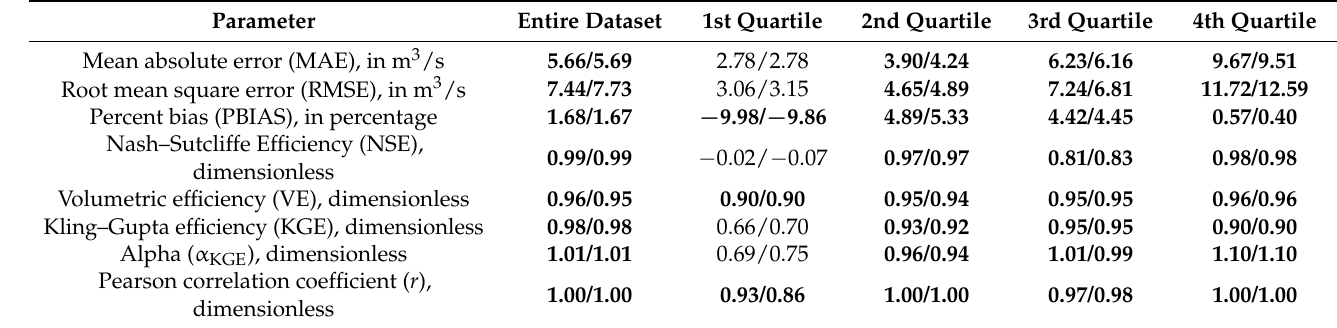
Figure A2. Comparisons of unfiltered (raw) radar-based discharge estimates (red), LOESS-filtered radar-based discharge estimates (royal blue), continuous USGS-streamgage-based discharge estimates (black), and USGS site visit stage discharge measurements (cyan), for the hybrid-radar-based, rapid- ϕ dataset, including a time series ( left ) and a scatterplot ( right ). Table A1. Goodness-of-fit statistics associated with radar-based and USGS-streamgage-based dis- charge measurements, from the fully radar-based, trained- ϕ dataset. Values in bold indicate they meet this study’s criteria for satisfactory performance defined in Section 2.3.2.